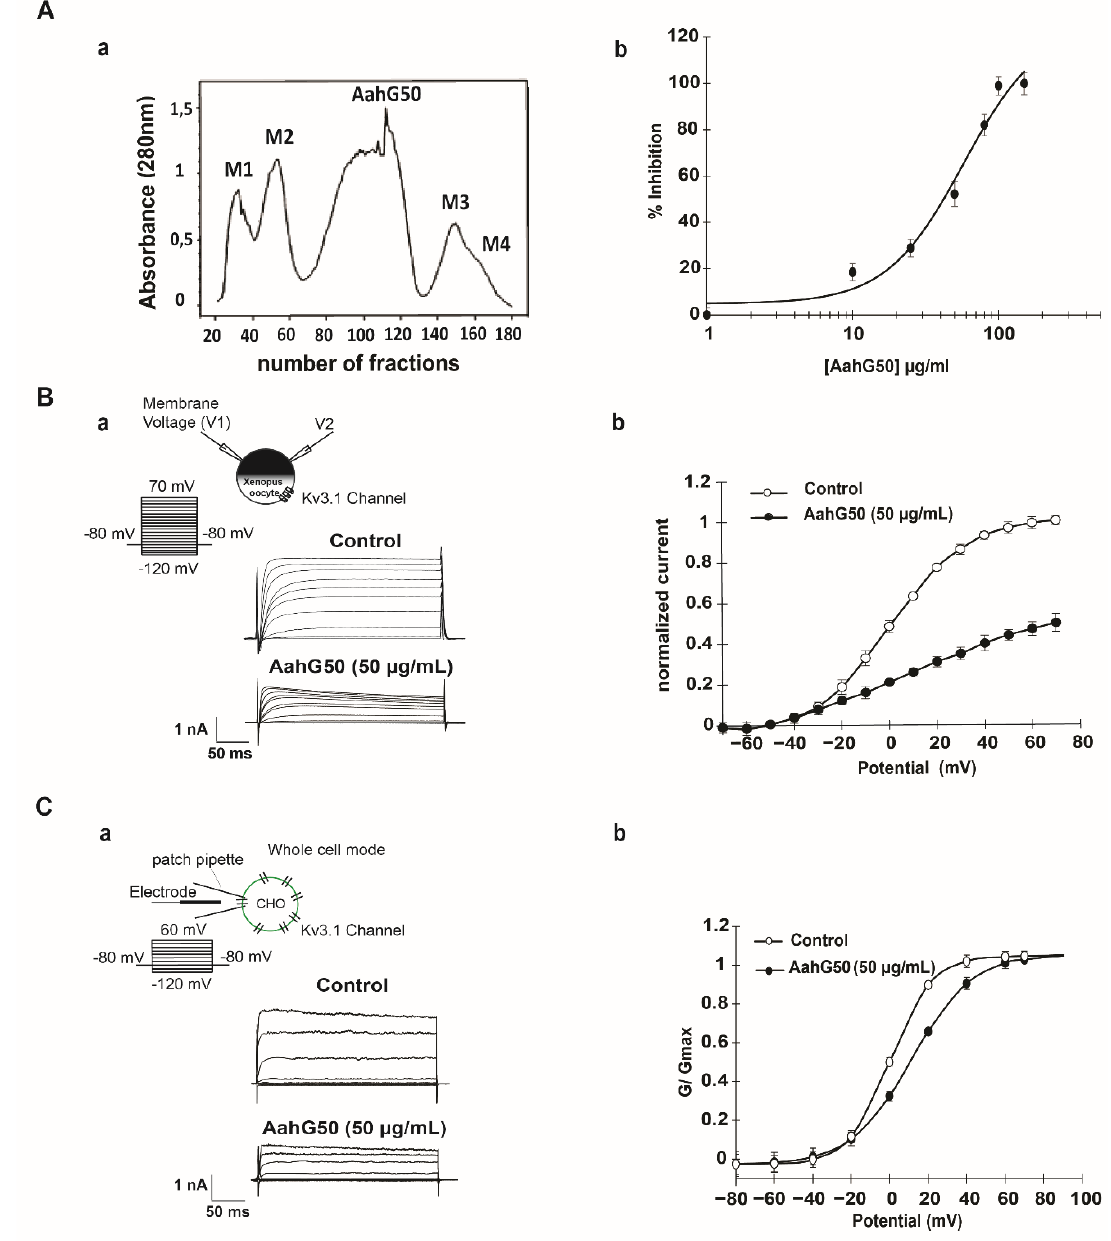
Figure 1. Inhibitory effect of AahG50 on Kv3.1 currents. ( Aa ) Purification of Androctonus australis hector scorpion venom. Dialyzed venom loaded into a Sephadex G50 column allowed the collect 5 fractions (M1, M2, AahG50, M3 and M4). ( Ab ) Dose–response curve of Kv3.1 channel inhibition at various concentrations of AahG50. Current amplitudes measured at the end of the depolarizing pulse (+60 mV), the percentage of inhibition plotted against respective concentrations of AahG50 (10, 25, 50, 100 and 150 µ g/mL). ( Ba ) Whole-cell currents, recorded in Xenopus oocytes, elicited by the application of 250 ms depolarizing pulses from − 120 mV to +70 mV in 10 mV increments, from a holding potential of − 80 mV, under control conditions and after the addition of 50 µ g/mL AahG50. ( Bb ) The normalized current voltage relationship of Kv3.1 currents in Xenopus oocytes plotted under control conditions and after the perfusion of 50 µ g/mL of AahG50. ( Ca ) Whole-cell currents, recorded in CHO cells, elicited by the application of 250 ms depolarizing pulses from − 120 mV to +60 mV in 20 mV increments, from a holding potential of − 80 mV, under control conditions and after the addition of 50 µ g/mL AahG50. ( Cb ) The normalized conductance-voltage relationship of Kv3.1 current in CHO cells plotted under control conditions and after the perfusion of 50 µ g/mL of AahG50.